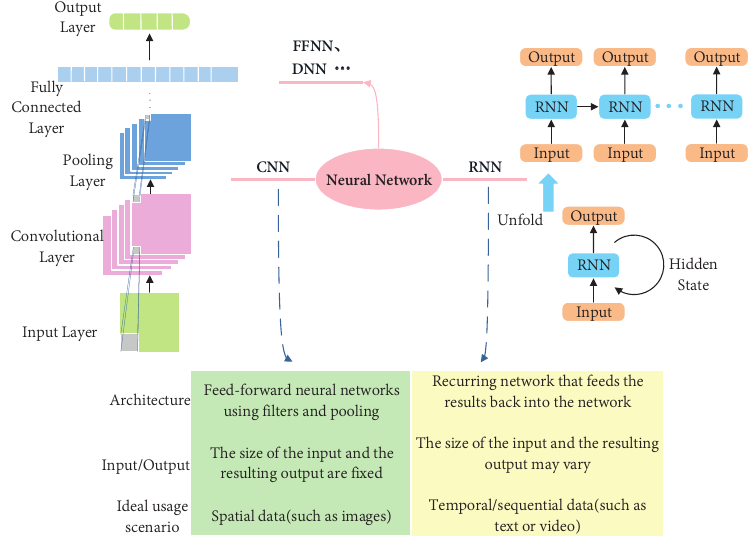
Figure 13. Structure block diagram of CNN and RNN. CNN is suitable for extracting unmarked features from hierarchical or spatial data. RNN is suitable for temporal data and other types of sequential